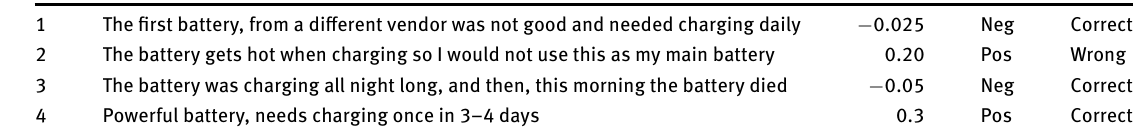
Table 3: Polarity Score and Sentiment of Review Texts for the Aspect “Battery”.